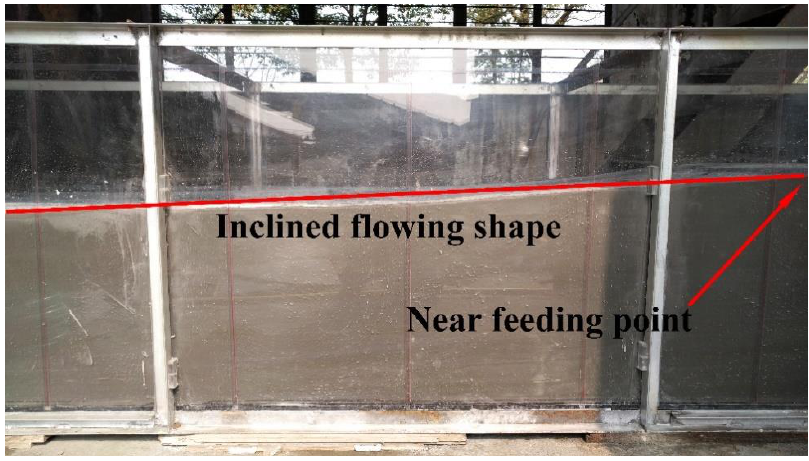
Figure 4. The final profile of backfill slurries after flowing in the test model.